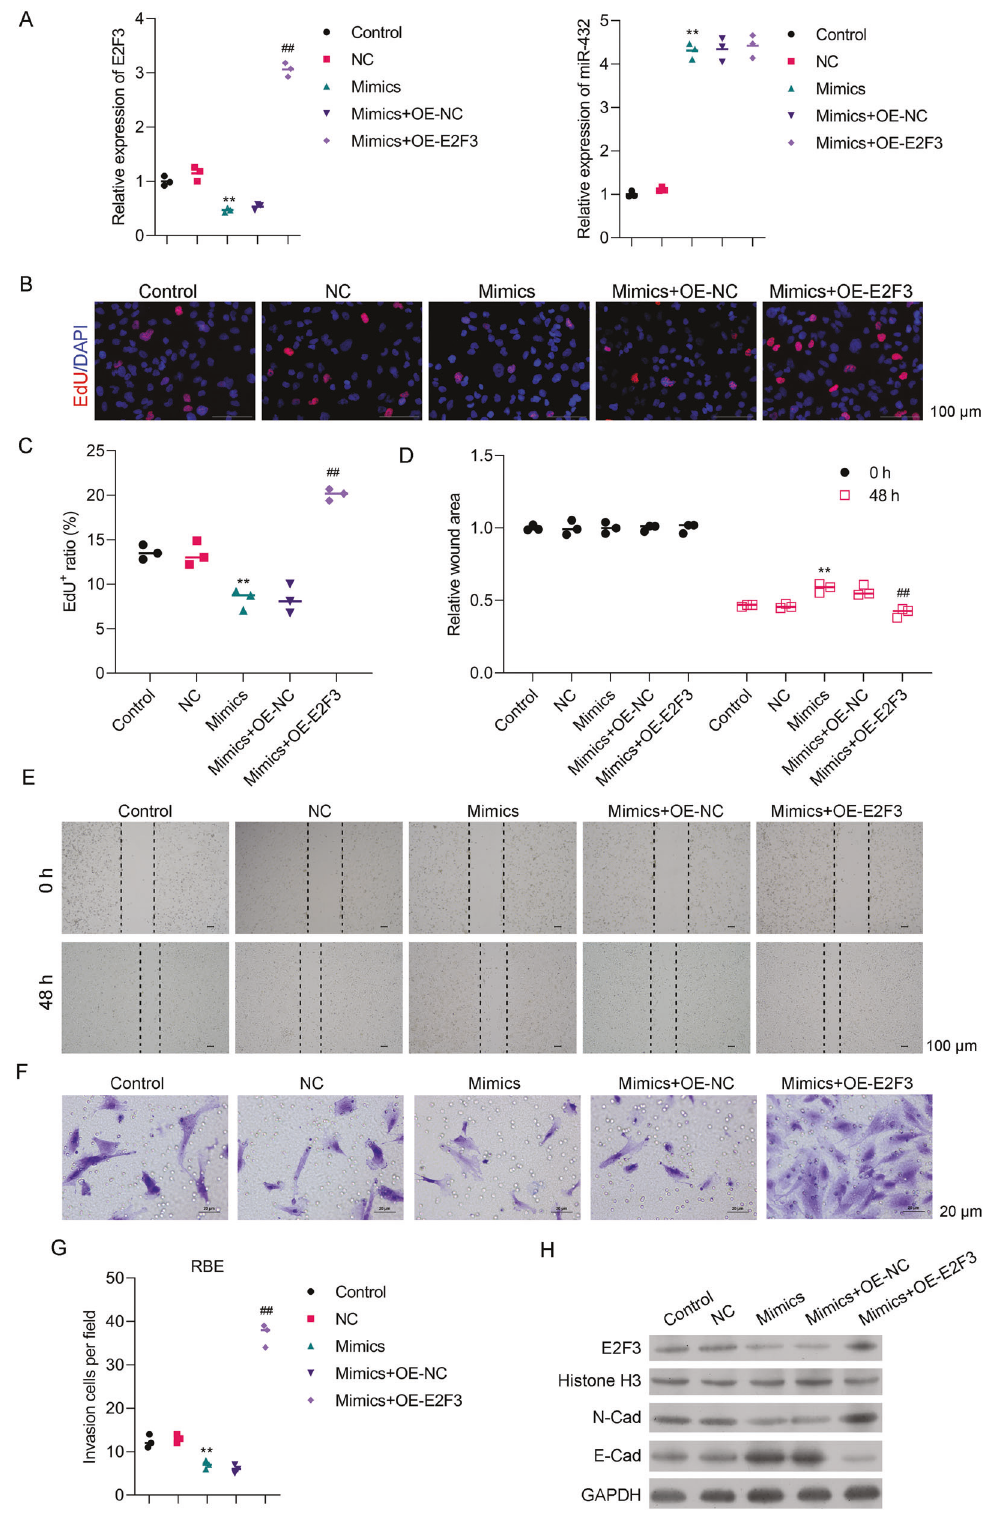
Fig. 7 An miR-432-5p/E2F3 axis was involved in regulating CCA cell proliferation, migration, and invasion. RBE cells were transfected with miR-432-5p mimics (mimics) or co-transfected with miR-432-5p mimics and a vector control (mimics + OE-NC) or an E2F3 overexpression plasmid (mimics + OE-E2F3). A E2F3 and miR-432-5p mRNA expression were detected by real-time PCR. B The respective images of Edu staining results. C The summary results of three different experiments are shown. D The wound healing results are shown. Cell monolayers were wounded and images were acquired at 0 and 48 h. E The respective images of wound healing assays are shown. F The wound healing assay results are shown. G The results of cell invasion assays as summarized from three independent experiments. H Western blot assays were performed using the indicated antibodies. ** p < 0.01 compared with the NC group. ## p < 0.01 compared with the mimics + OE-NC group.